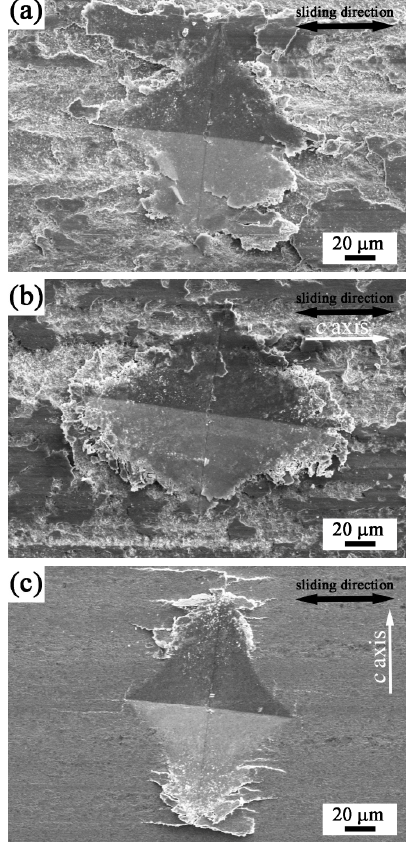
Fig. 6 Wear damages on different texture surfaces of tailored Ti 3 AlC 2 ceramic when tested at 1 N: (a) TTS, (b) TSS-1, and (c) TSS-2.